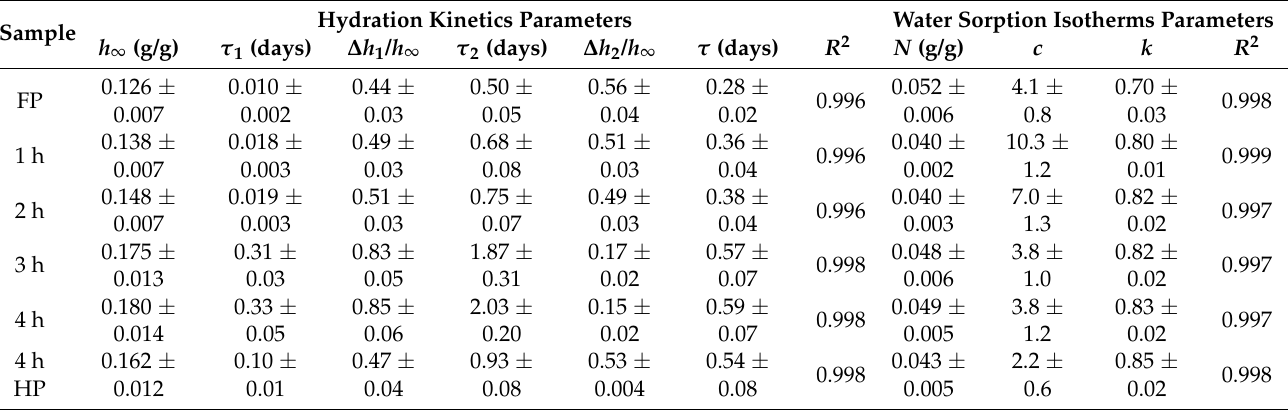
Table 3. Hydration kinetics and GAB parameters fitted for the water sorption kinetics curves and water sorption isotherms of Figure 4a,b. The reported values of the statistical parameter R 2 indicate the goodness of